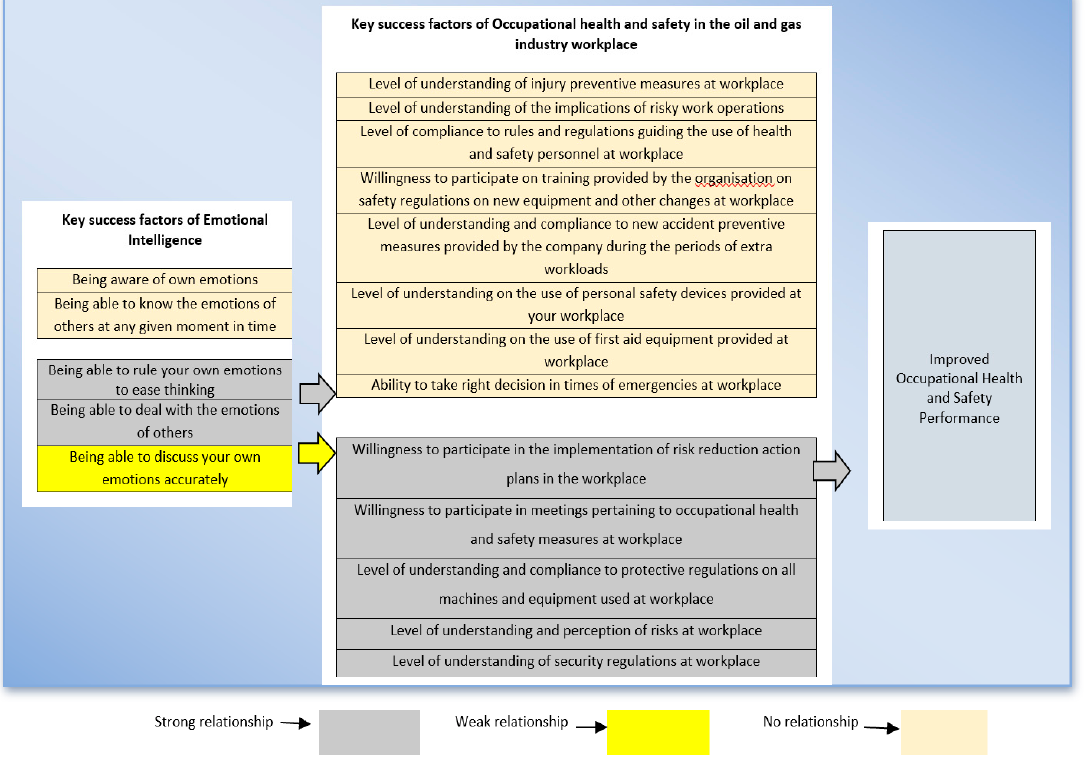
Figure 5. Model showing the extent to which emotional intelligence affects occupational health and safety performance in the oil and gas industry.